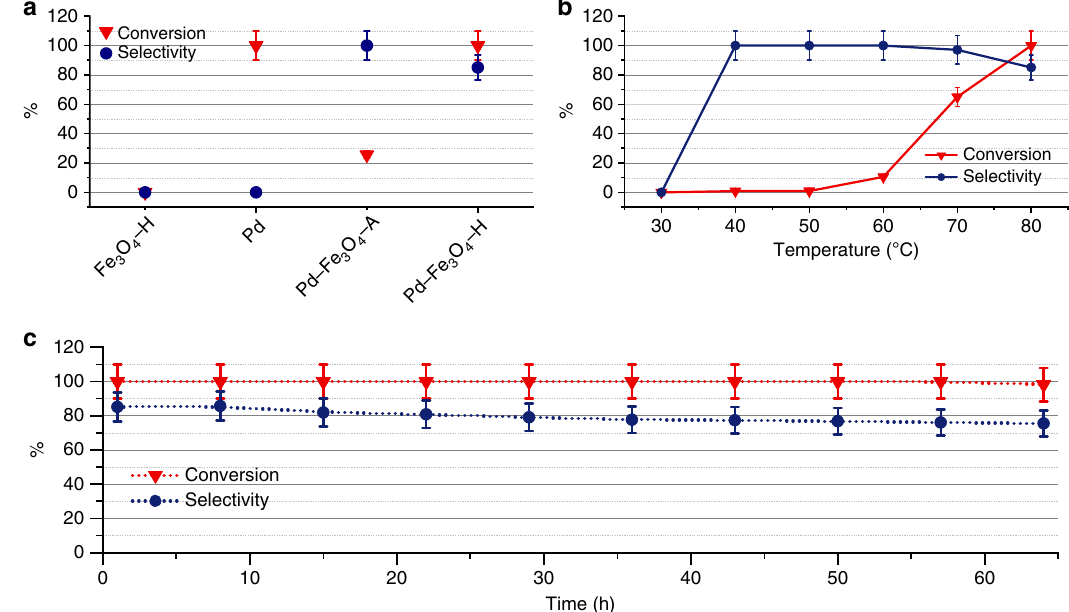
Fig. 5 Catalytic performances of the prepared samples for the semi-hydrogenation of C 2 H 2 . a The comparison of catalytic performance of different systems; b light-off curves of the Pd – Fe 3 O 4 – H catalyst; c stability of Pd – Fe 3 O 4 – H under high conversion. Reaction conditions: m (catal.) = 15 mg; v (gas) = 50 sccm (0.6 sccm C 2 H 2 , 3 sccm H 2 , 46.4 sccm He). The reaction temperature in a and c is 80 °C. Error bars represent the instrumental error (±10 %). Source data are provided as a Source data fi